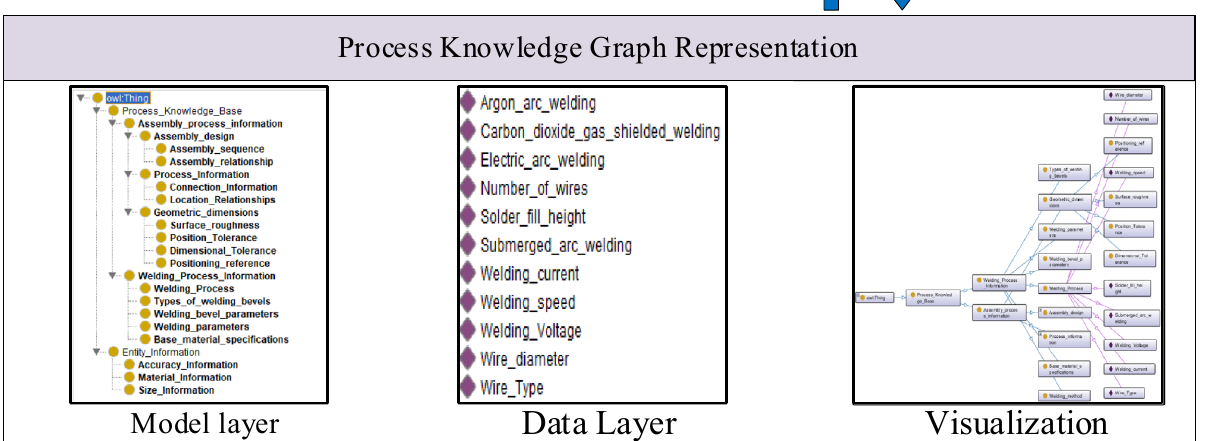
Figure 8. Process knowledge graph modeling system for ship heterogeneous